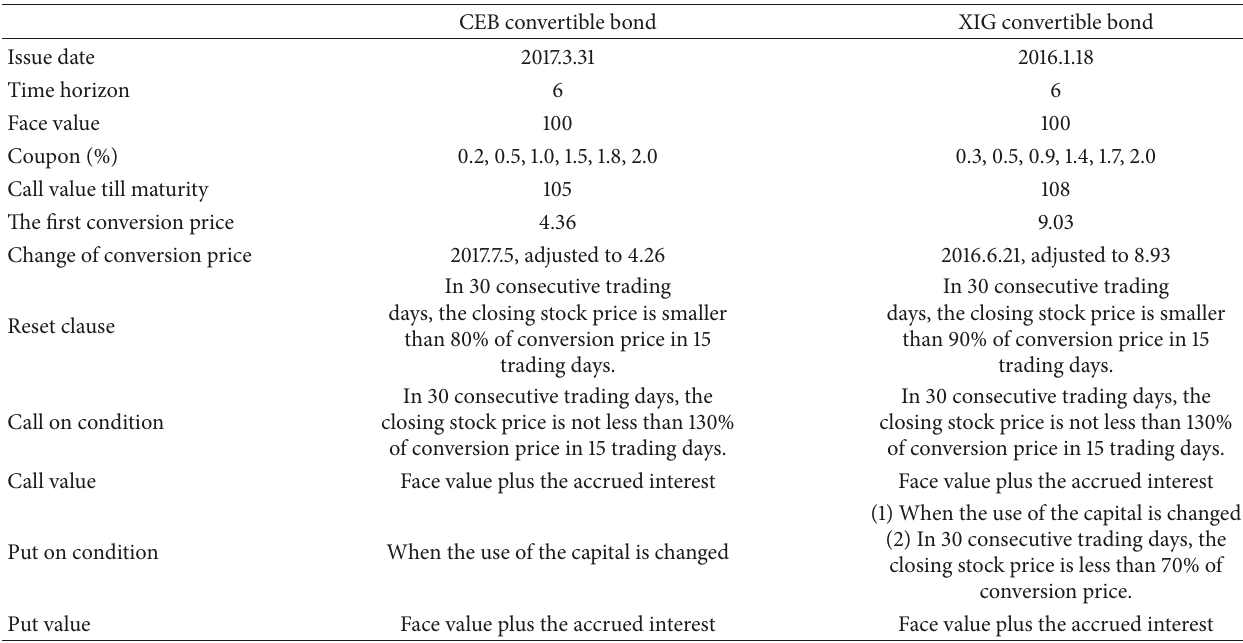
Table 2: CEB and XIG convertible bonds.